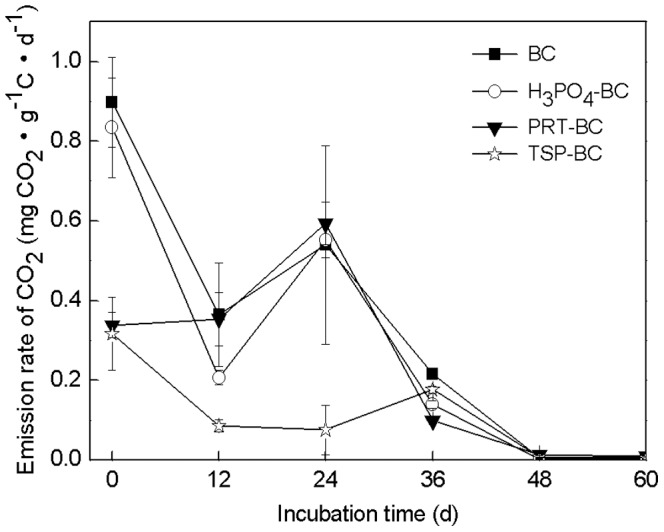
Emission rates of CO2 from the biochars during aerobic incubation.